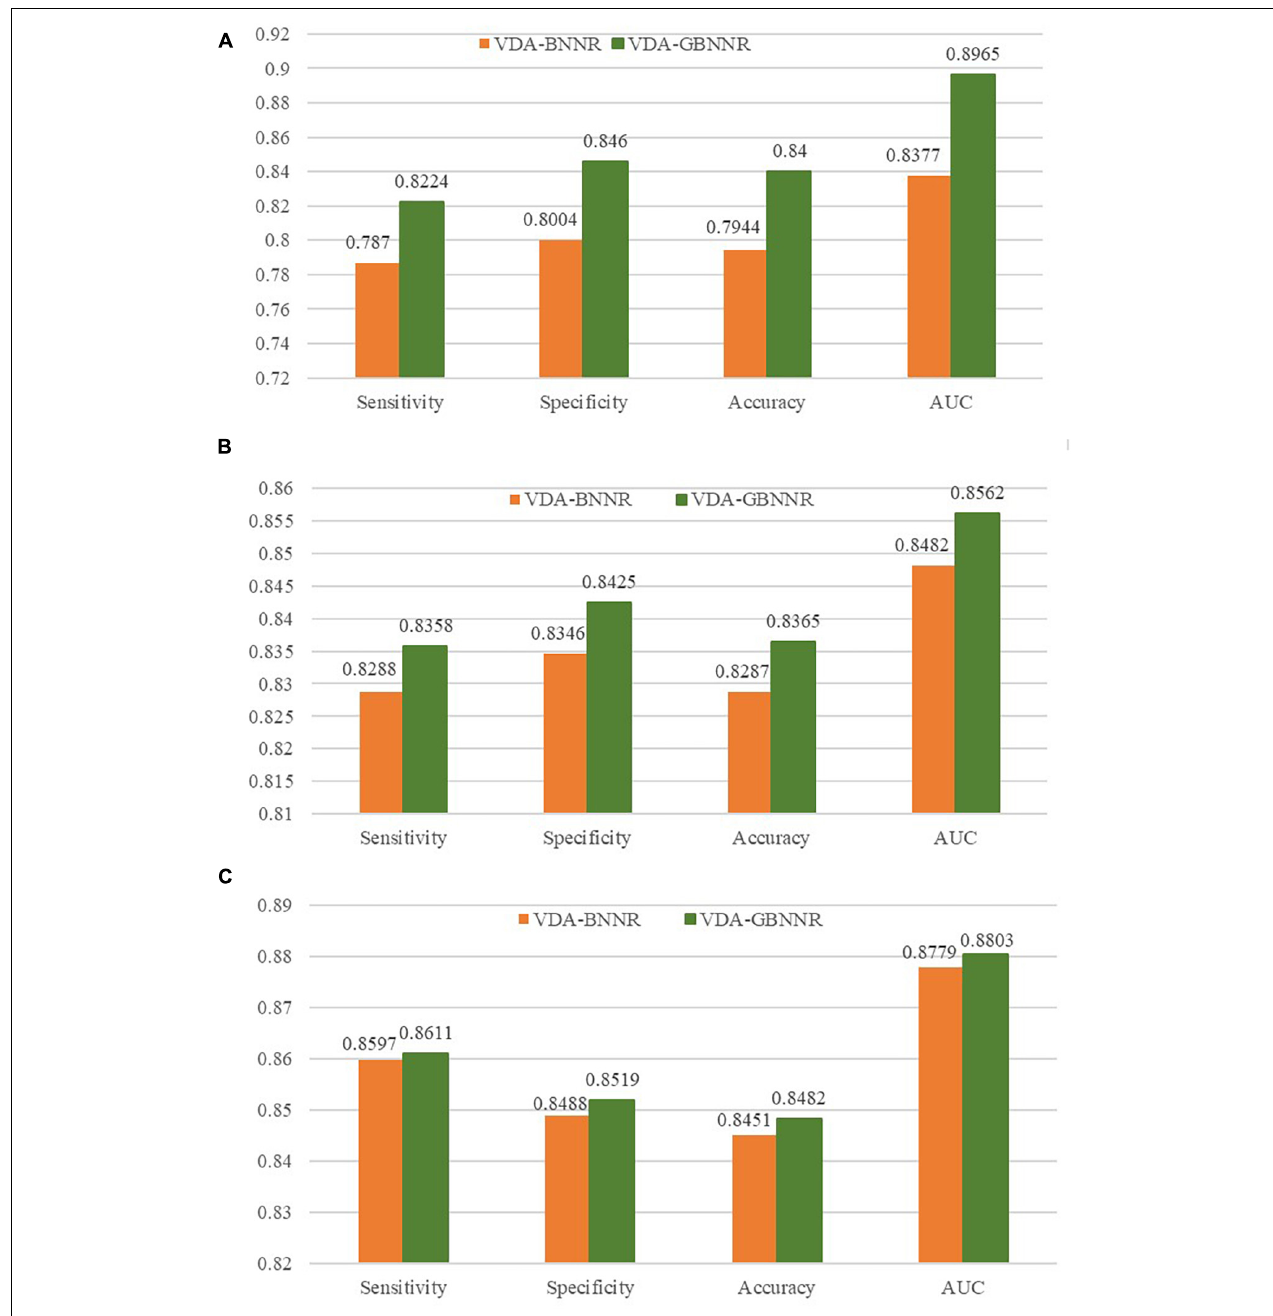
FIGURE 3 | Performance comparison between VDA-BNNR and VDA-GBNNR on three datasets. (A) Performance comparison between VDA-BNNR and VDA-GBNNR on dataset 1. (B) Performance comparison between VDA-BNNR and VDA-GBNNR on dataset 2. (C) Performance comparison between VDA-BNNR and VDA-GBNNR on dataset